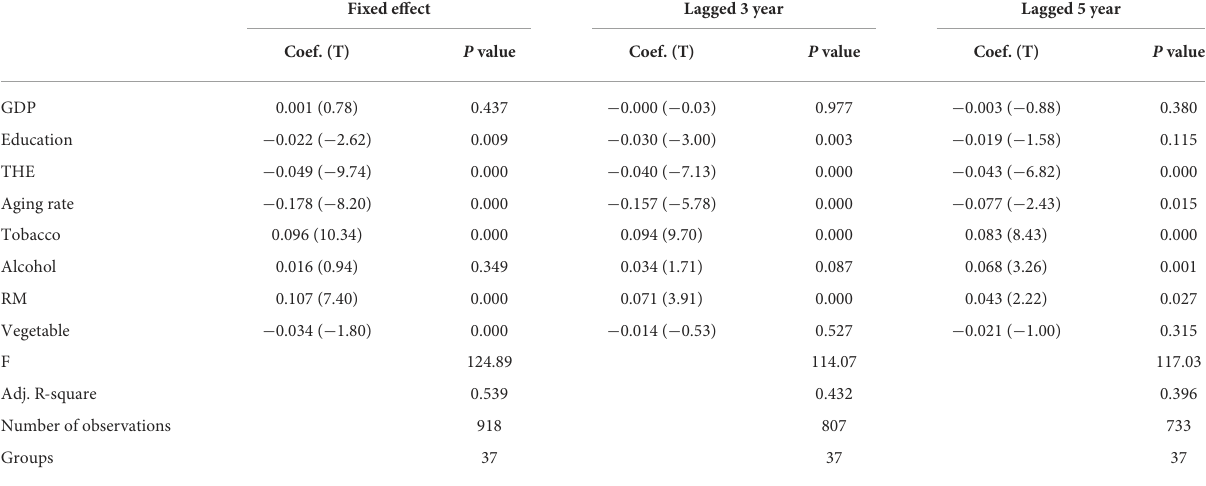
TABLE 4 Association between GDP, education, THE, aging rate, RM, vegetable consumption and cancer death by fixed-effect model,